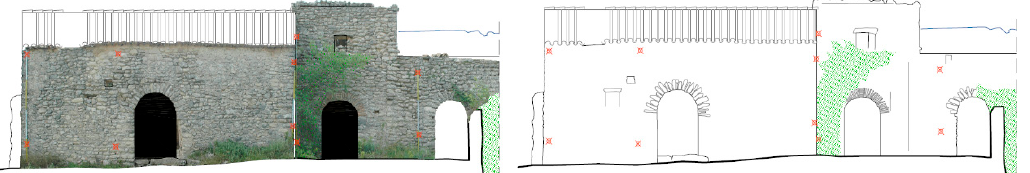
Figure 4. Example of the data collection process that has been applied to all the cases: Photogrammetry and architectural drawing.